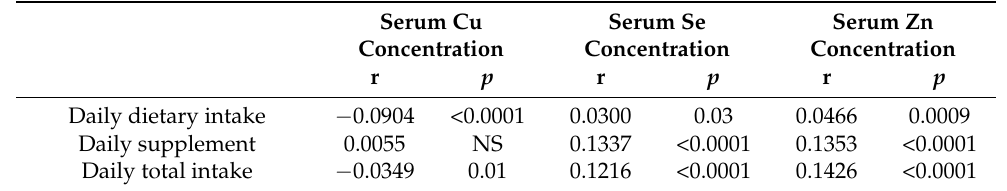
Table 4. Correlation of serum copper, selenium, and zinc concentrations with daily dietary intake,